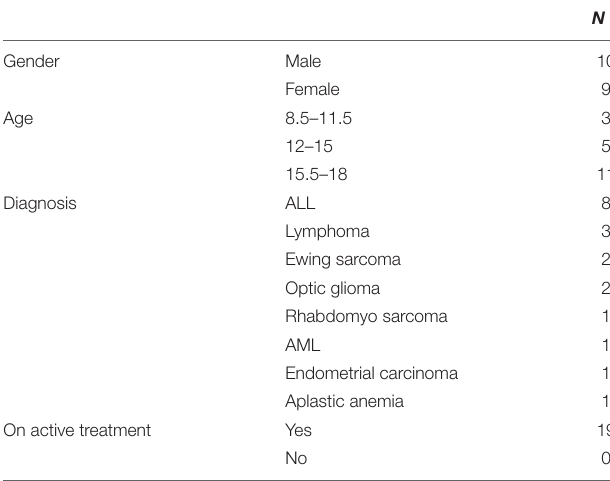
TABLE 1 | Characteristics of the 19 participating